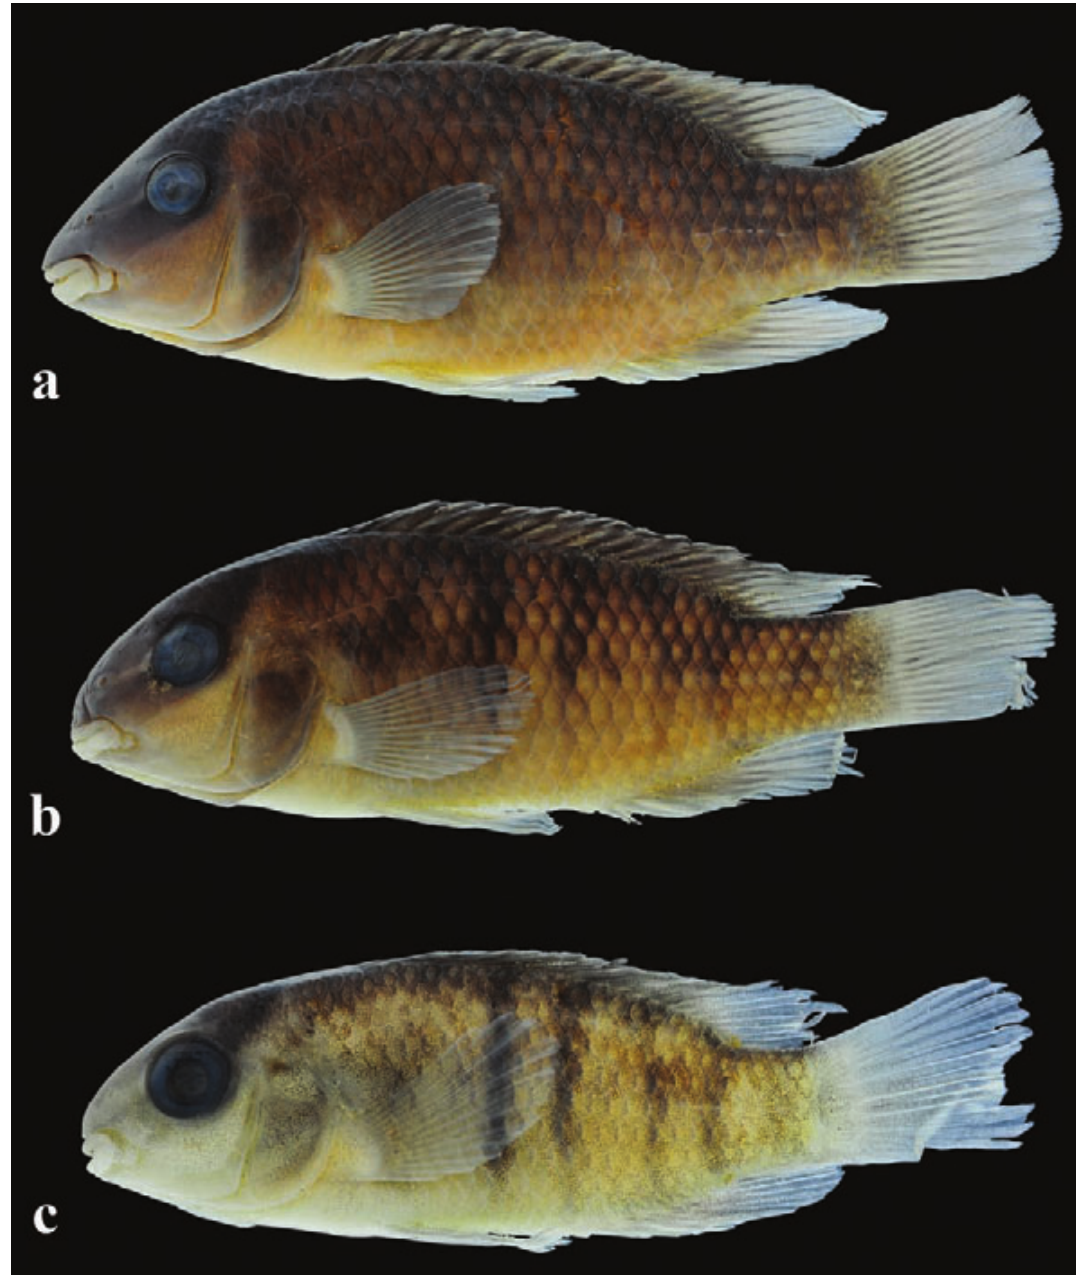
Fig. 9. Mazarunia charadrica , ontogenetic changes in overall body shape and melanic coloration; a ) adult, 67.2 mm SL, b